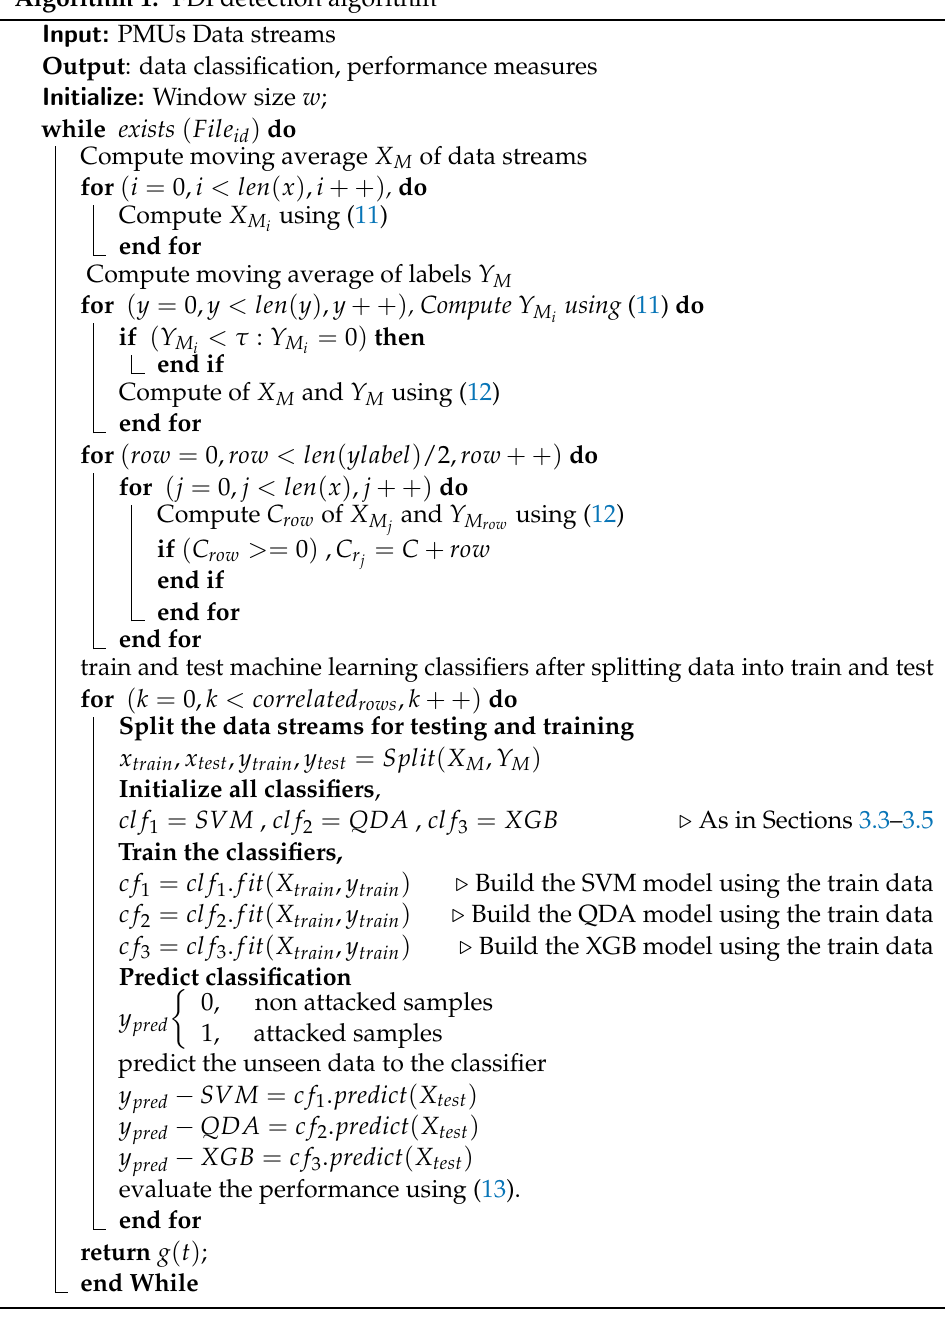
Algorithm 1: FDI detection